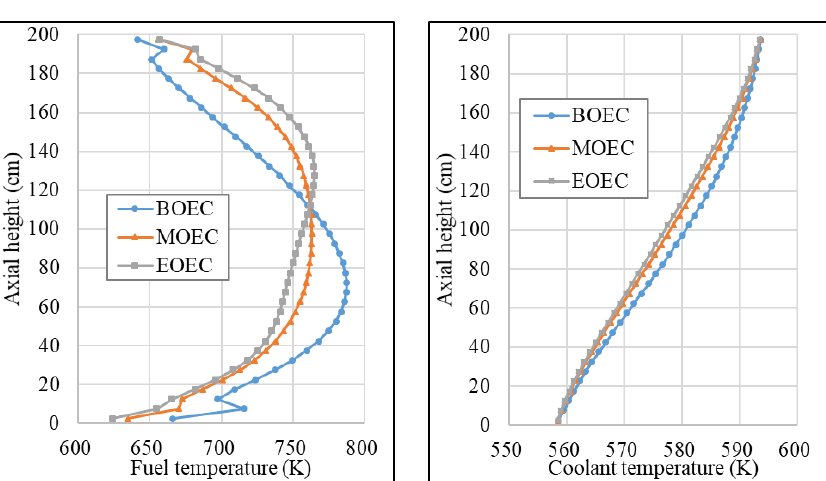
Figure 6: Axial Fuel and Coolant Temperature Distributions